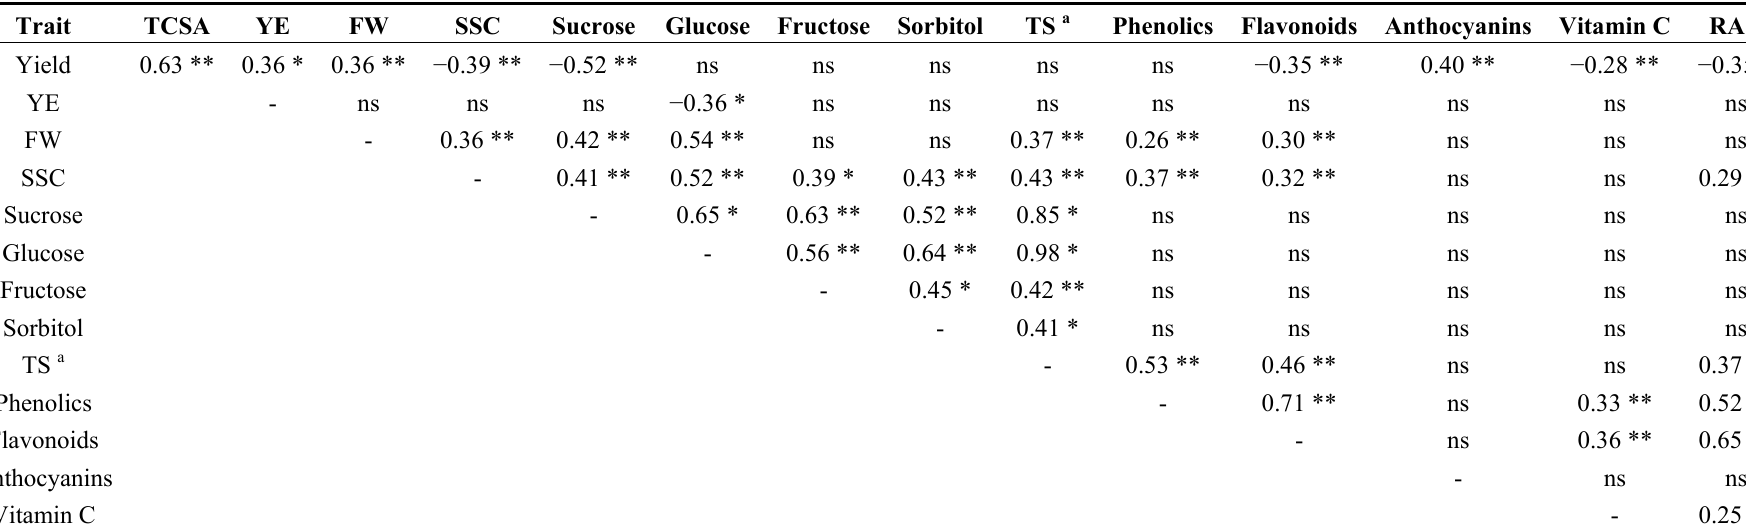
Table 5. Pearson’s correlations coefficients between some agronomical, basic fruit quality and phytochemical traits on different plum rootstocks budded with “Catherine” cultivar. Trait TCSA YE FW SSC Sucrose Glucose Fructose Sorbitol TS a Phenolics Flavonoids Anthocyanins Vitamin C RAC Yield 0.63 ** 0.36 * 0.36 ** − 0.39 ** − 0.52 ** ns ns ns ns ns − 0.35 ** 0.40 ** − 0.28 ** − 0.35 * YE - ns ns ns − 0.36 * ns ns ns ns ns ns ns FW - 0.36 ** 0.42 ** 0.54 ** ns SSC - 0.29 ** Sucrose - 0.65 * 0.63 ** 0.52 ** 0.85 * ns ns ns ns ns Glucose - 0.56 ** 0.64 ** 0.98 * ns Fructose - 0.45 * ns ns Sorbitol - 0.41 * ns ns ns ns ns TS a - 0.53 ** 0.46 ** ns ns 0.37 ** Phenolics - 0.71 ** ns 0.33 ** 0.52 ** Flavonoids - ns 0.36 ** 0.65 ** Anthocyanins - ns ns Vitamin C - 0.25 ** * and ** represent statistical significance at p ≤ 0.05 and p ≤ 0.01 respectively; ns, not significant. Abbreviations: TCSA, trunk cross-sectional area; YE, yield efficiency; FW, fruit weight; SSC, soluble solid content; TS a , Total sugars, the sum of sucrose, glucose, fructose, and sorbitol for each genotype, analyzed by HPLC and RAC, relative antioxidant